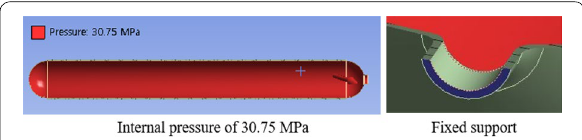
Figure 18 Load and boundary conditions of static structural analysis